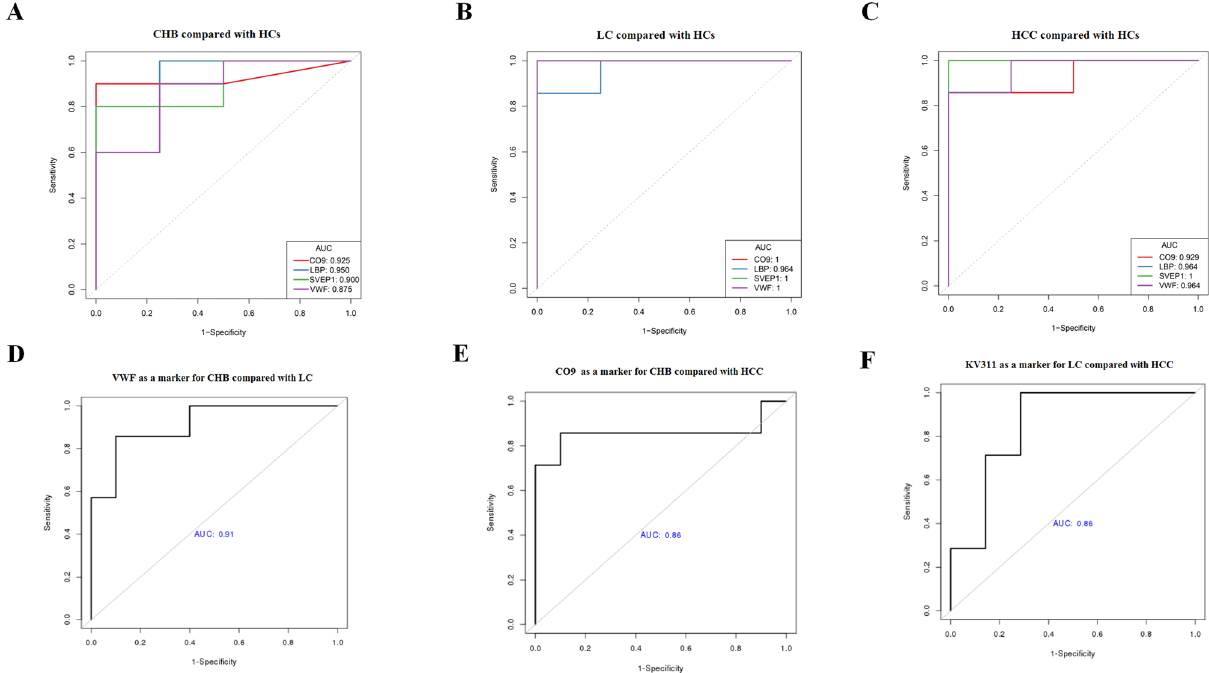
Figure 5. Diagnostic prediction (Receiver Operating Characteristics (ROC) curves and area under the curve (AUC) values) of the selected serum liquid biopsy biomarkers. AUC values were calculated by stepwise logistic regression algorithm, and then the graphs were drawn by R’s own program. CO9, LBP, SVEP1 and VWF levels for diagnosing patients with chronic hepatitis B virus infection (CHB) ( A ), liver cirrhosis (LC) ( B ), and hepatocellular carcinoma (HCC) ( C ) compared with healthy controls (HCs). AUC values of VWF as a marker for diagnosing CHB compared with LC ( D ). AUC values of CO9 as a marker for diagnosing CHB compared with HCC ( E ). AUC values of KV311 as a marker for diagnosing LC compared with HCC ( F ).